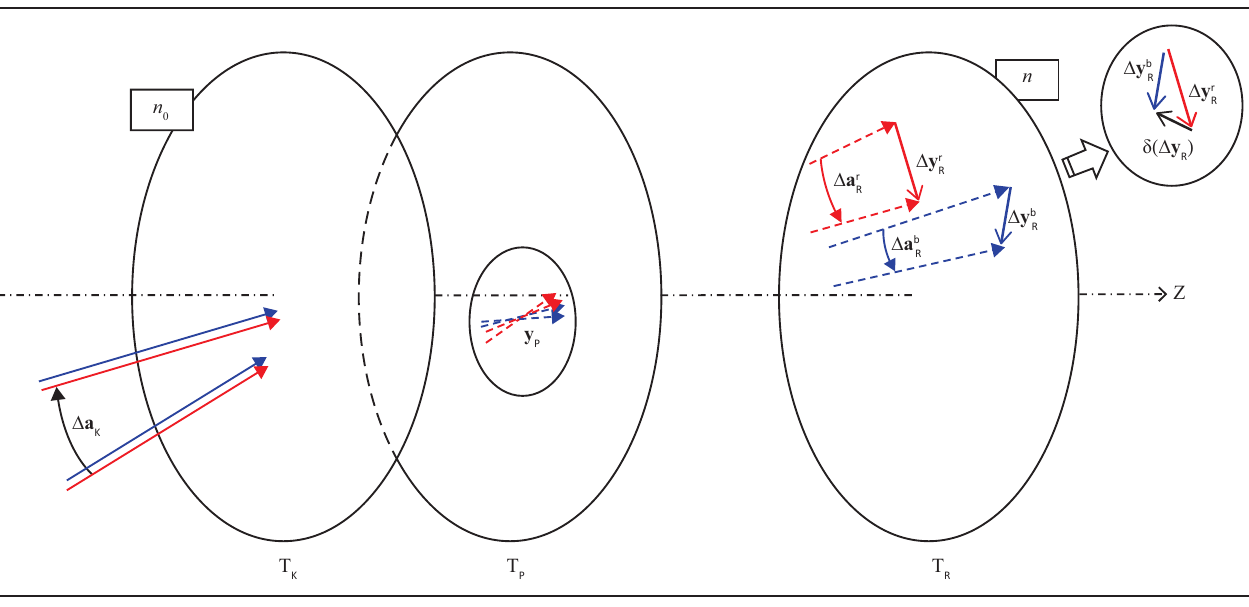
from a distant object with angular size ∆a . We K K ) is the vector from the position of the red R ). All ray positions, R